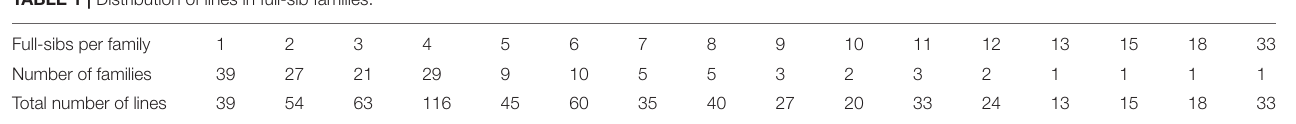
TABLE 1 | Distribution of lines in full-sib